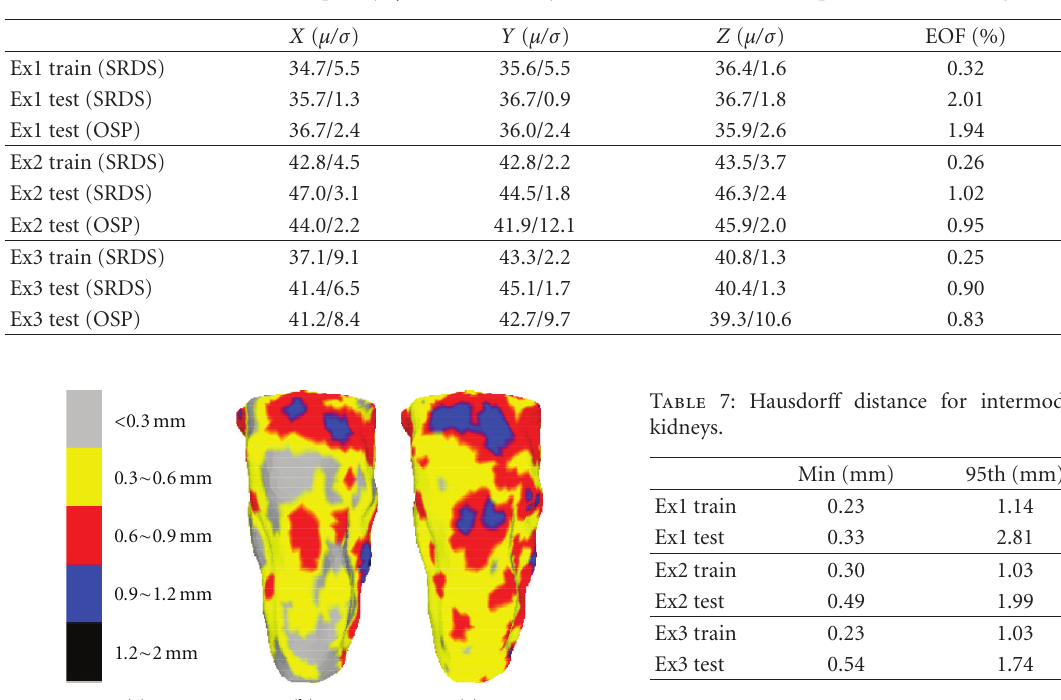
Table 6: Sparsity ( μ/σ ) and accuracy evaluation for intermodel experiment with kidneys.